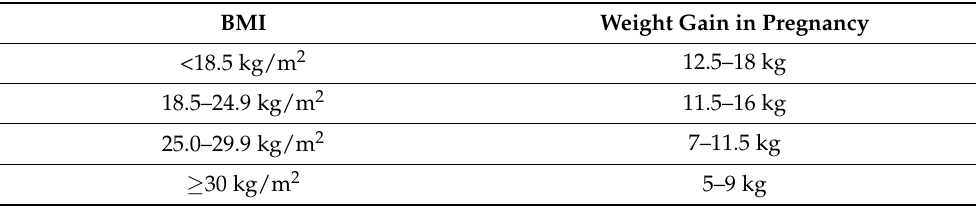
Table 3. Weight gain in relation to baseline body weight